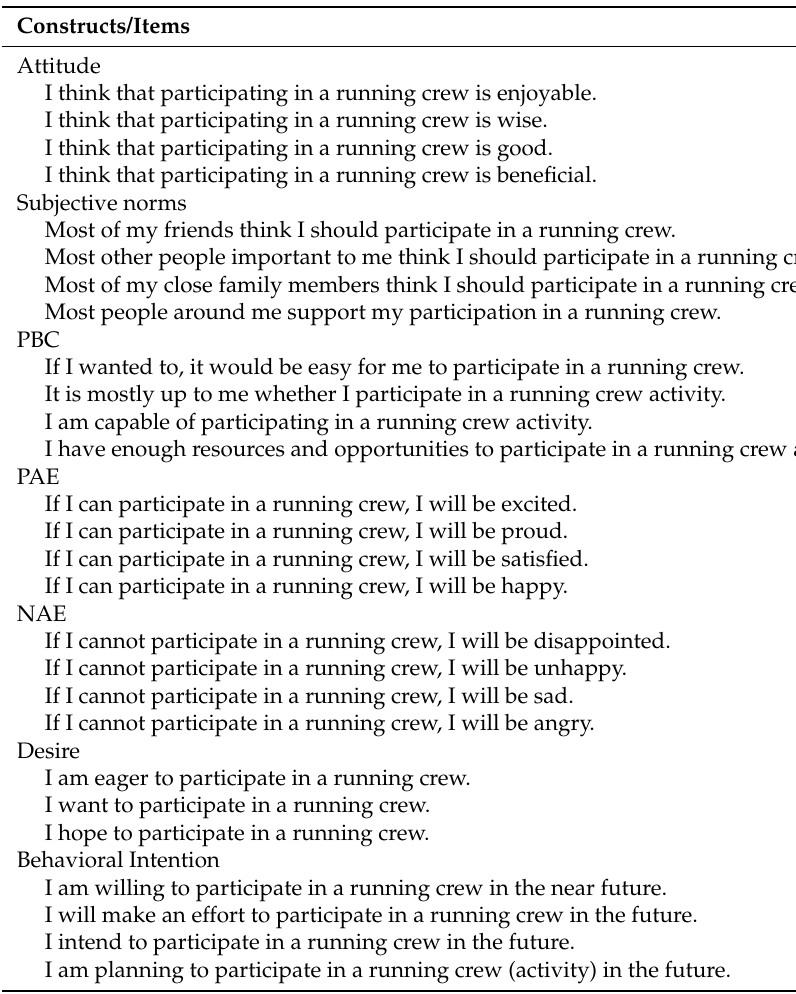
Table 1. Constructs and items used in this